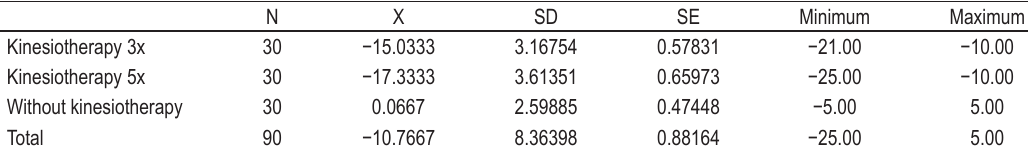
TABLE 6. Average values of the oswestry disability index differences before and after treatment N X SD SE Minimum